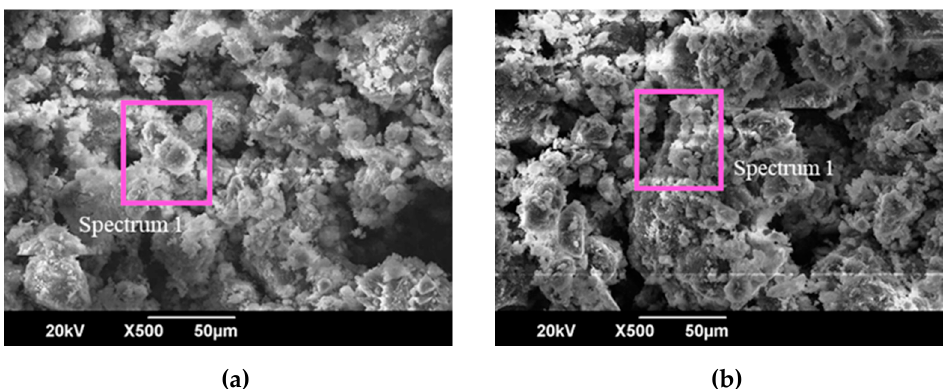
Figure 16. SEM photos of samples of lateritic-cement-additive after wetting-drying cycles ( a ) LC-5-0-1 After wetting-drying cycles, and ( b ) LC-5-2-1 After wetting-drying cycles. Table 8. Chemical elements of lateritic–cement–additive mixtures.